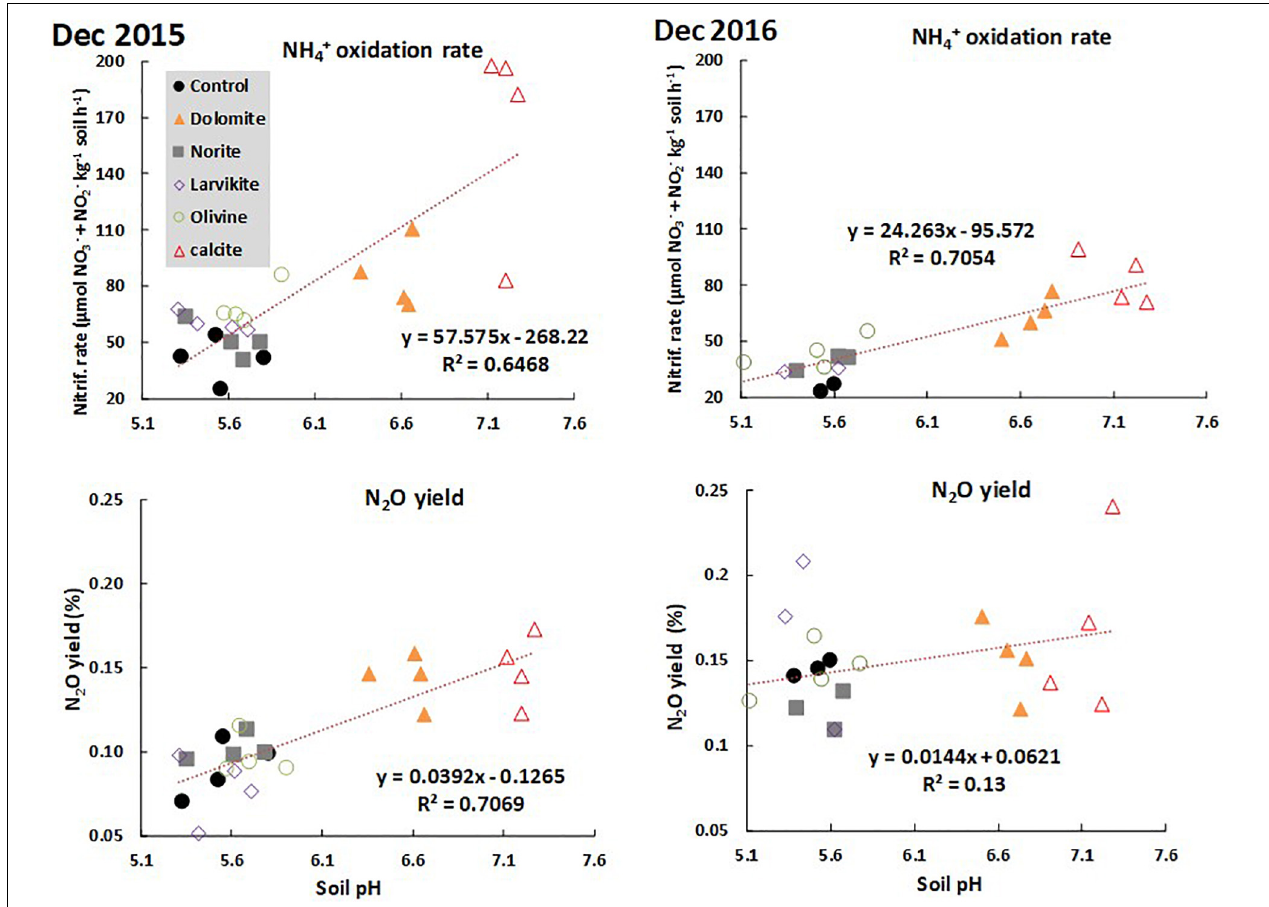
FIGURE 3 | Relationship between soil slurry pH, NH 4 + oxidation rate and N 2 O yield (% of oxidized N emitted as N 2 O-N) in oxic nitrification assays. The plotted values are single flask values for four field replicates of each treatment. Plotted values are from two incubation experiments with soils collected from field 15 and 27 months after application of